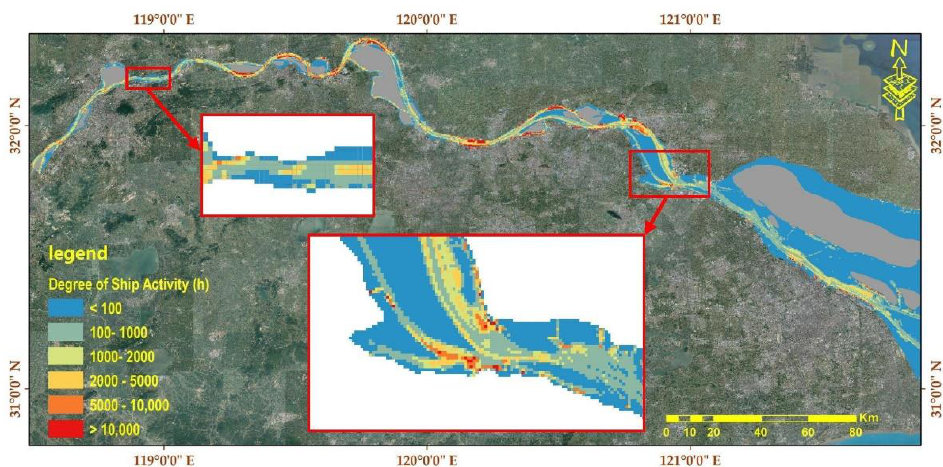
Figure 4. DSA distribution in the lower reaches of the Yangtze River.